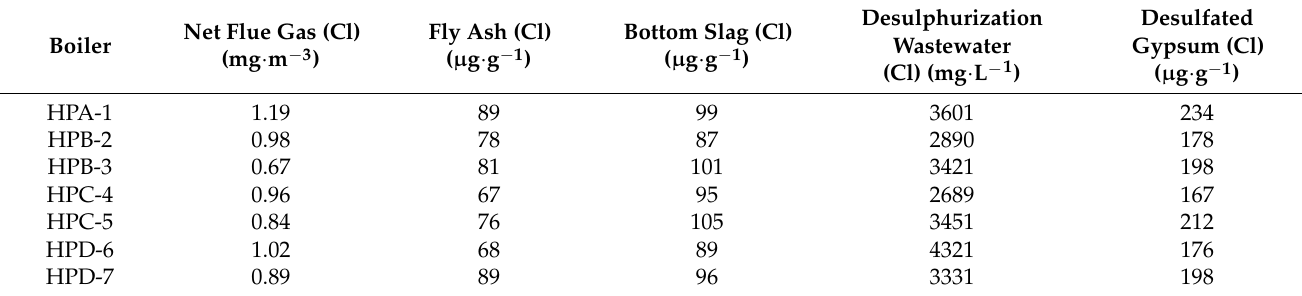
Table 5. Person Correlation Analysis between Cl and Coal Quality in Coal.